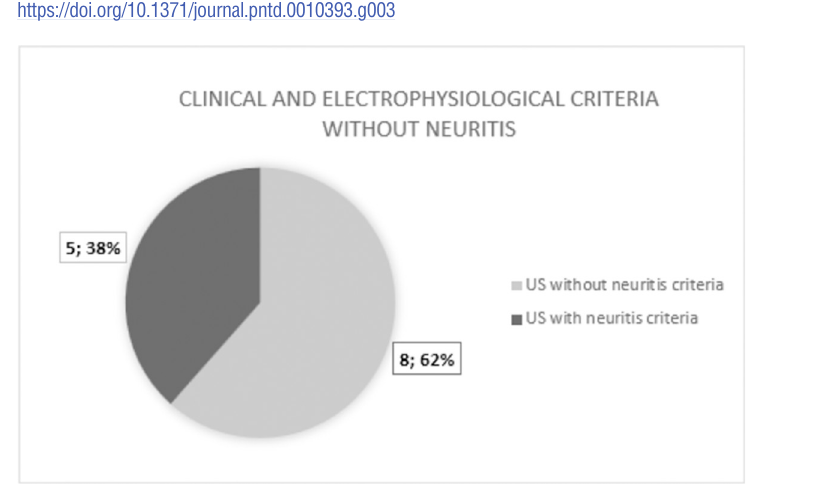
Fig 4. Comparison of patients classified as ´no neuritis´ by clinical and electrophysiological criteria (reference criteria) with the ultrasound classification.